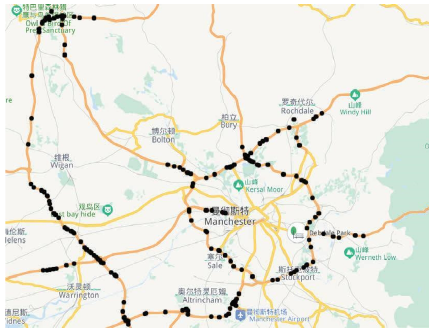
Figure 4: Te distribution of monitoring points in the HW-ENG